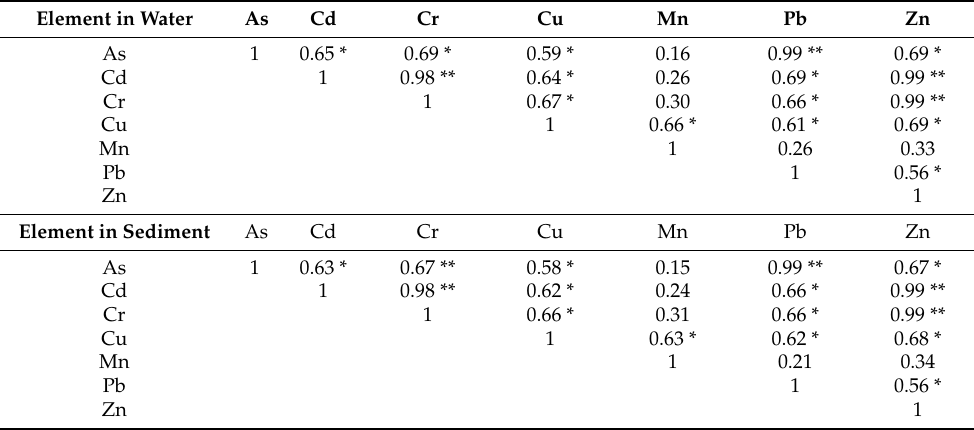
Table 4. Correlation matrix of PTEs in water and sediment of the river sections in manganese mining areas. Element in Water As Cd